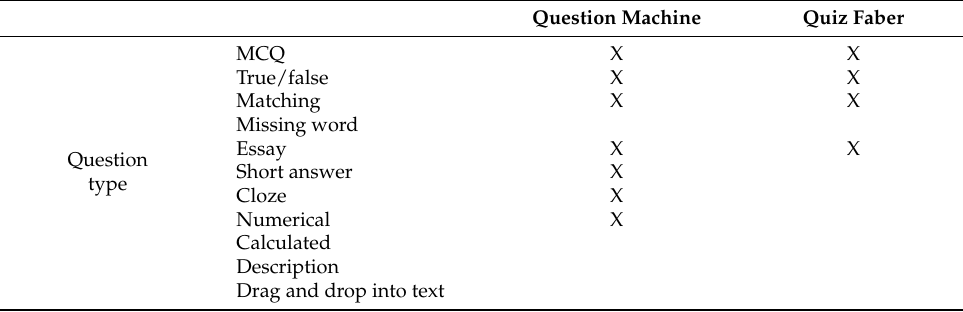
Table 2. Comparison of the question types handled by specialised